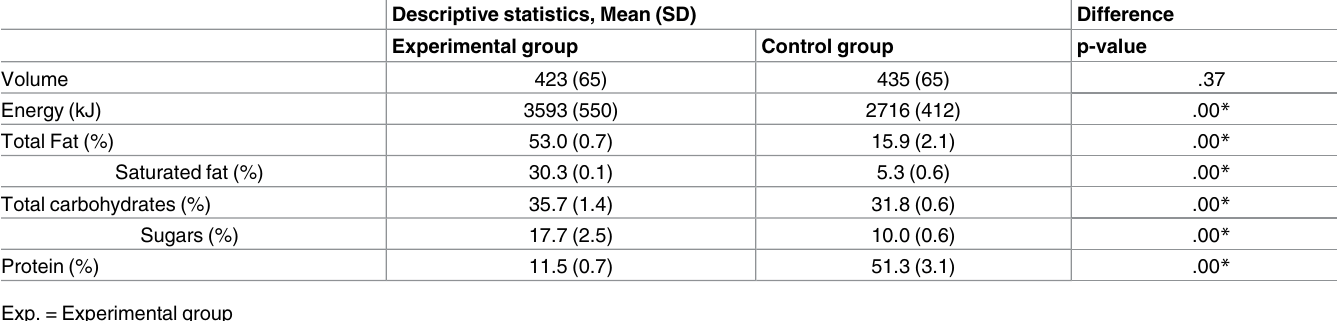
Table 3. Nutritional breakdown of breakfasts consumed , averagedacross test